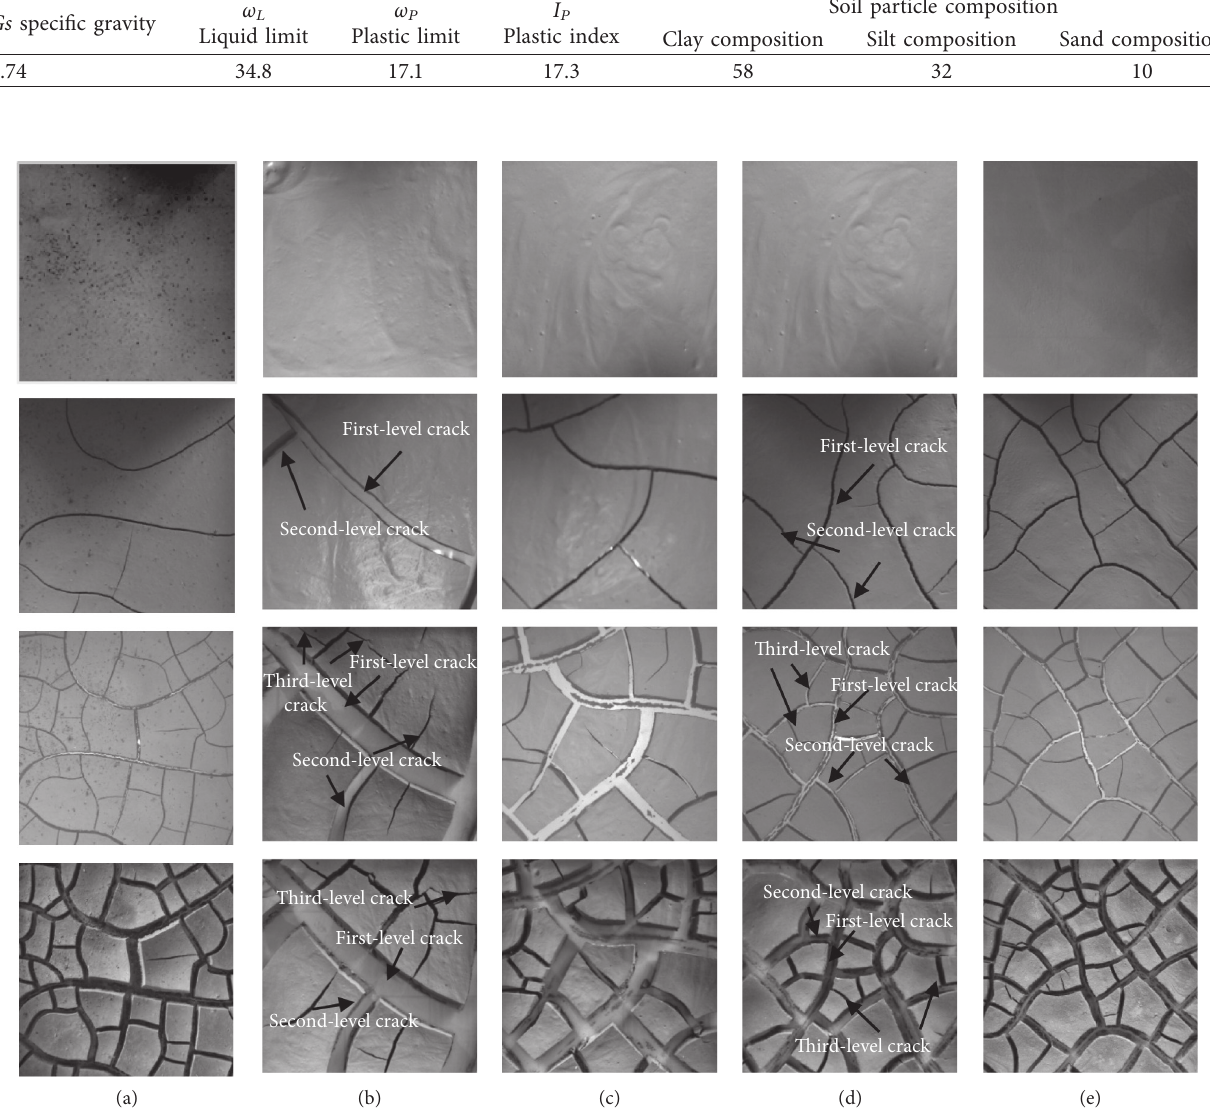
Figure 1: Different stages of water loss cracking of clay with sodium carbonate: (a) 0mol/L. (b) 0.1mol/L. (c) 0.2 mol/L. (d) 0.3 mol/L. (e) 0.4mol/L.